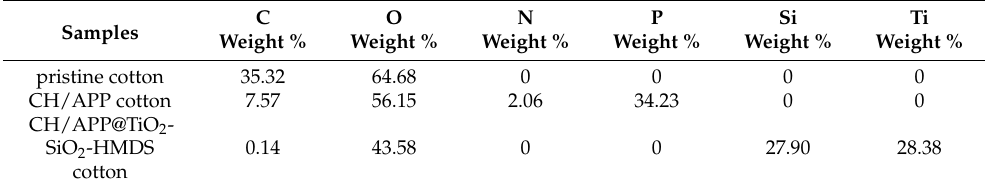
Table 1. The elemental content in weight % of pristine cotton and treated cotton. Samples